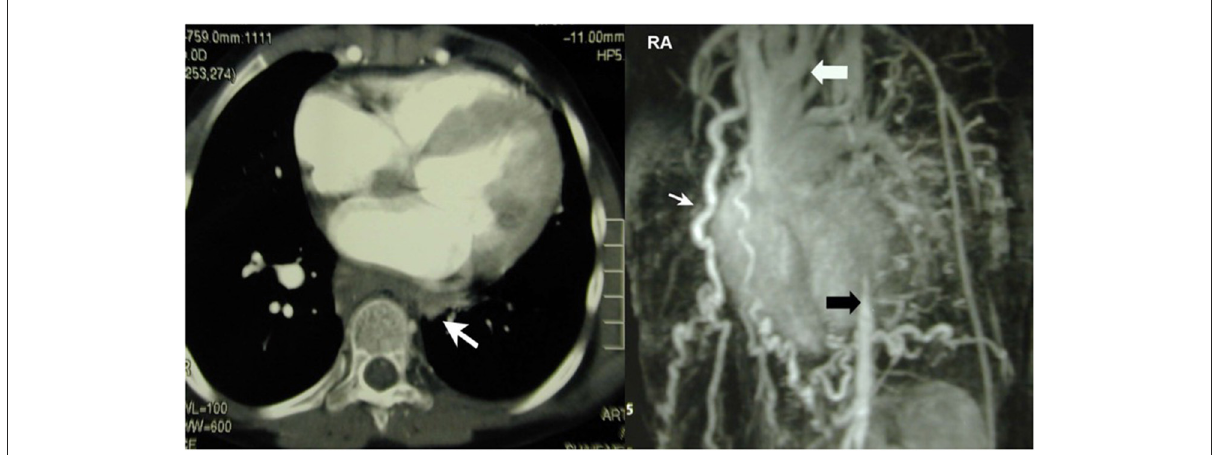
FIGURE1 Left: CT-scan showing segmental agenesia (white arrow) of the descending aorta. Right: Huge network of collaterals. The missing segment lies between the distal aortic arch (white arrow) and the thoraco-abdominal junction (black arrow). Reproduced with permission from ICVTS 2003; 2:231–3.